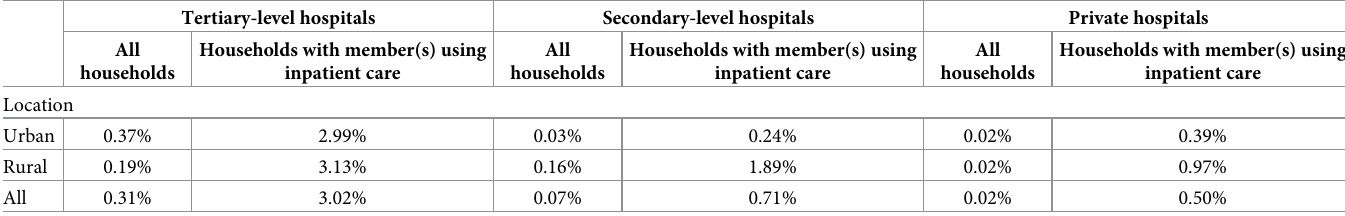
Table 2. Extent of catastrophic health expenditure on inpatient care, by hospital type, in Mongolia. Tertiary-level hospitals Secondary-level hospitals Private hospitals All Households with member(s) using households inpatient care